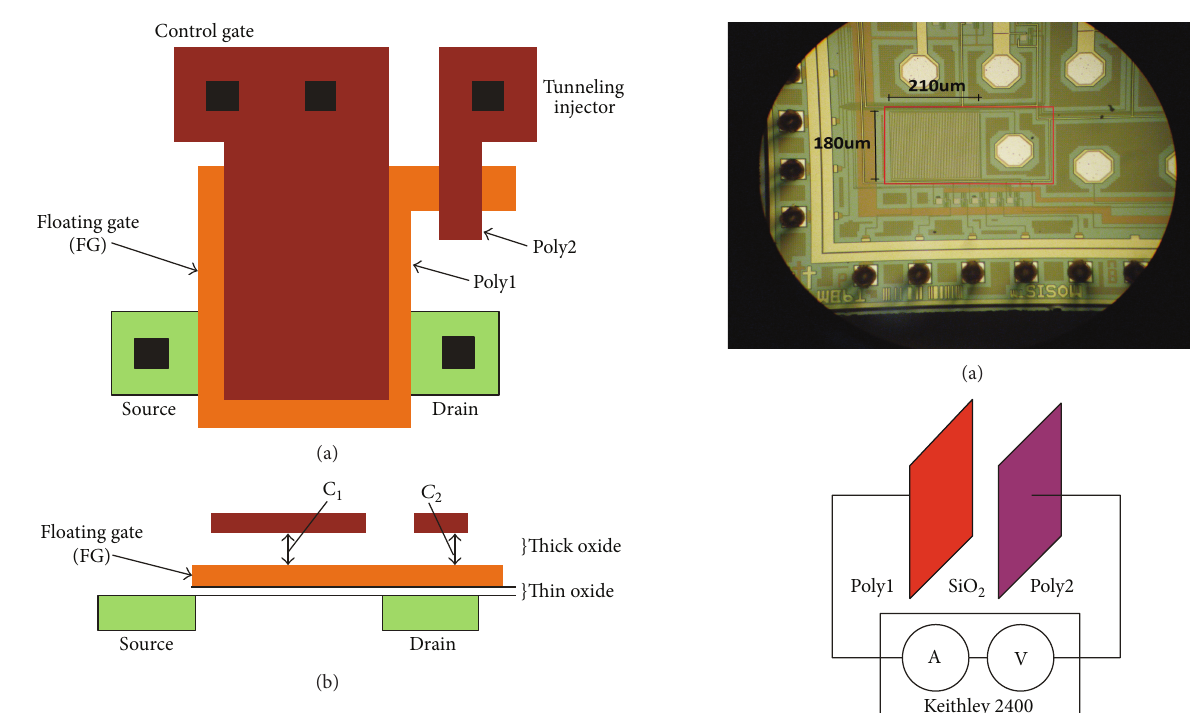
Figure 3: Topological design of an FGMOS transistor with a tunneling injector: top view and side view.